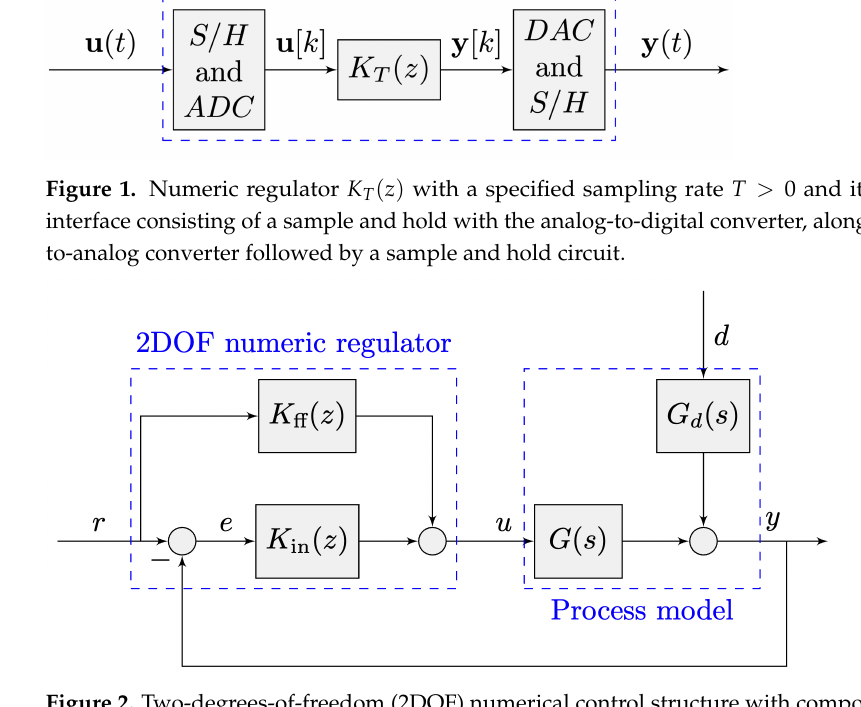
Figure 2. Two-degrees-of-freedom (2DOF) numerical control structure with components K in ( z ) and K ff ( z ) , designed for the process models G ( s ) with disturbance dynamics G d ( s )